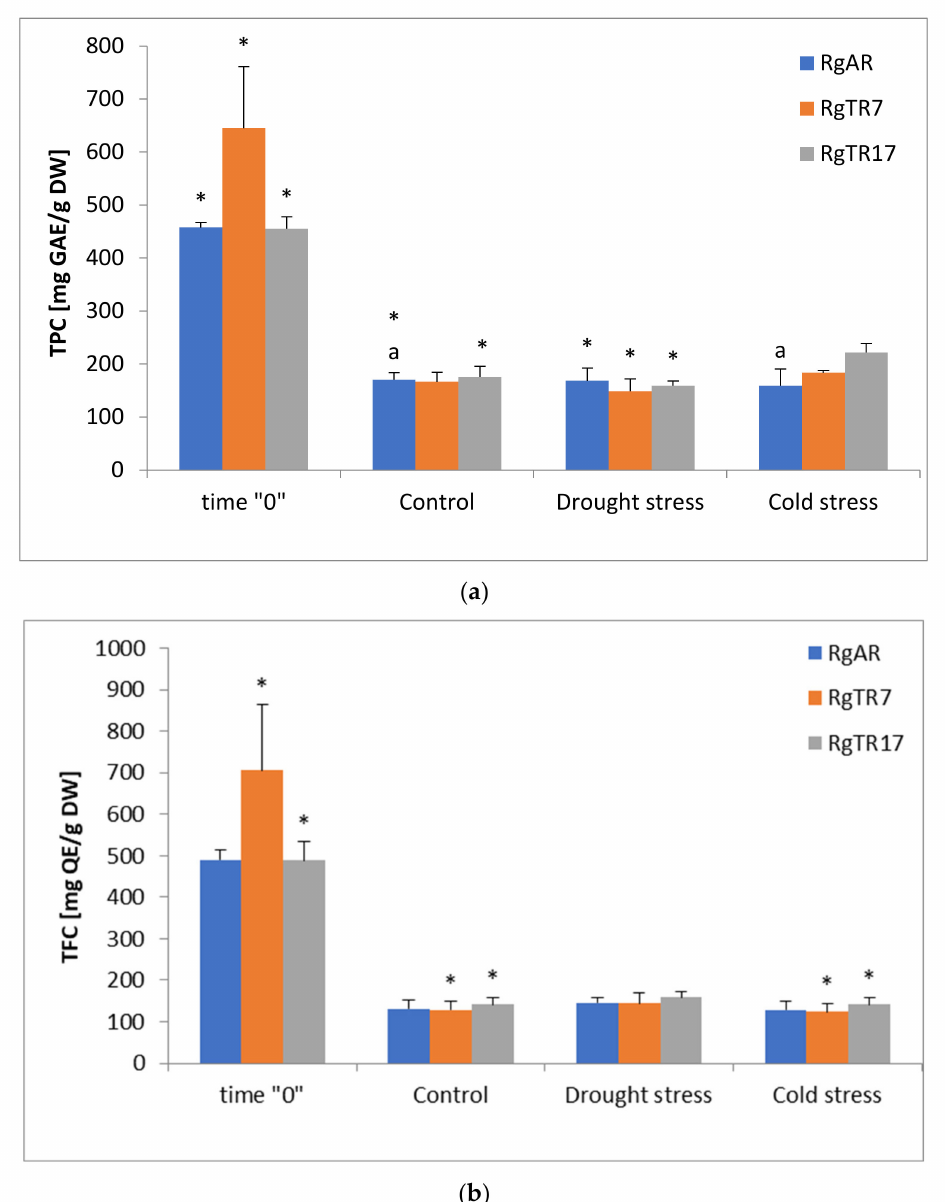
Figure 1. ( a ) Total phenolic (TPC) and ( b ) total flavonoid (TFC) content determined in R. graeca roots cultivated under various conditions. RgAR—anatomical roots; RgTR7—hairy root line TR7; RgTR17—hairy root line TR17; time “0”—28-day-old roots at time of inoculation; Control—roots cultivated without any treatment for 14 days; Drought stress—roots treated by drought stress for 14 days; Cold stress—roots treated by cold stress for 14 days. The same letters indicate statistically significant differences ( p ≤ 0.05) in relation to control within the same root lines between treatments. Asterisks (*) indicate statistically significant differences ( p ≤ 0.05) in relation to time “0” within the same root lines between